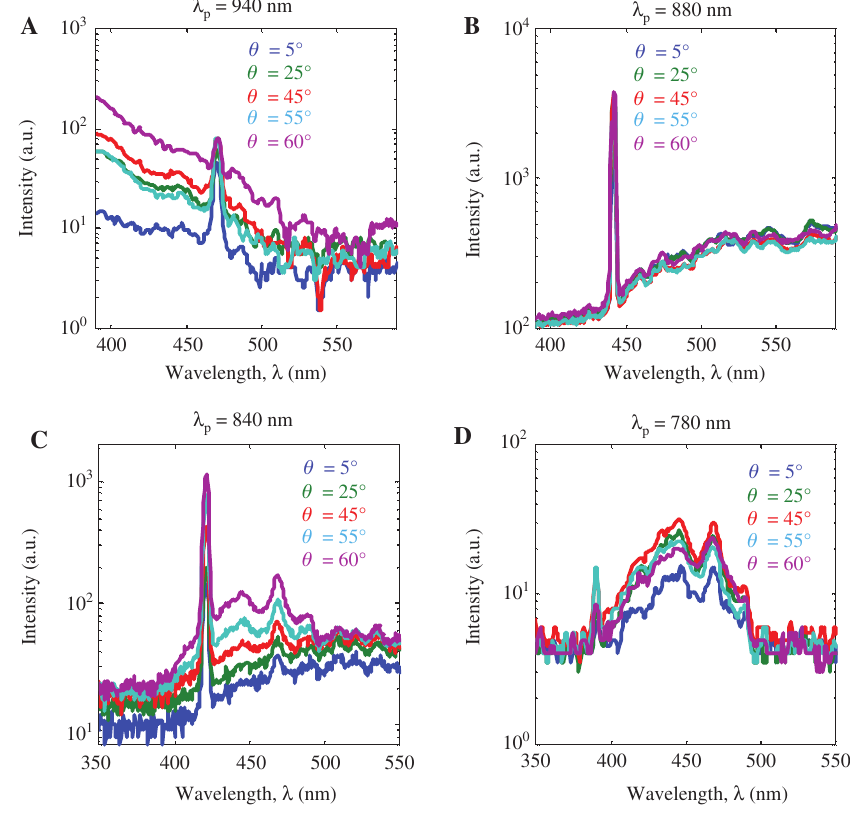
Figure 4: Evolution of the SESHG signal versus the excitation angle at the four critical excitation frequencies: (A) evolution of the SESHG peak at 470 nm near the first fundamental LP mode band edge, (B) evolution of the SESHG peak at 440 nm near the second fundamental LP mode band edge, (C) evolution of the SESHG peak at 420 nm near the PM wavelength and (D) evolution of the SESHG peak at 390 nm near the second-harmonic LP mode band edge. The (fundamental) pump wavelength in each case is shown by λ